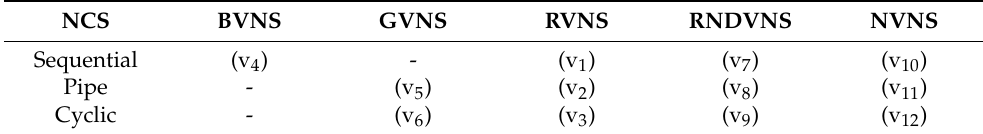
Table 2. Neighborhood change steps considered in VNS